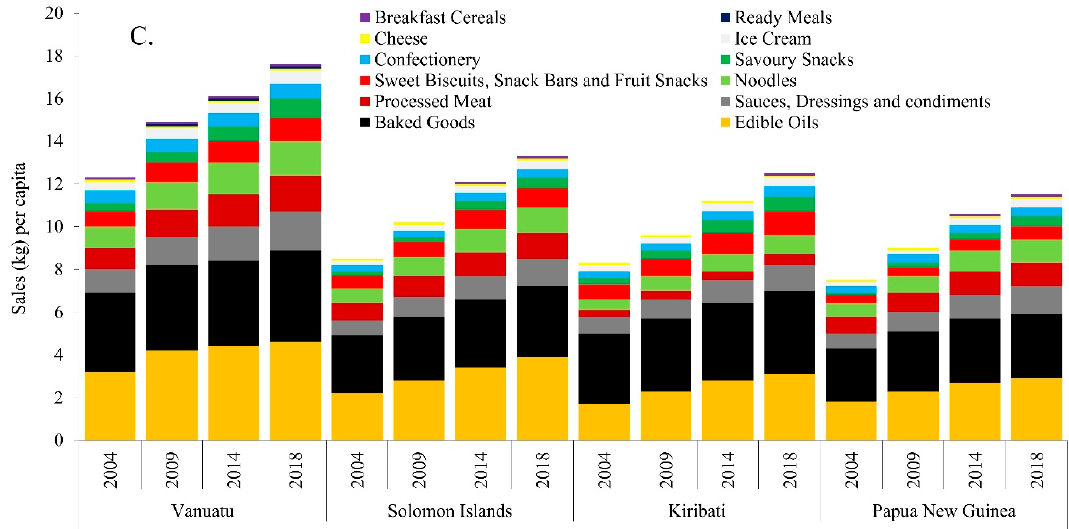
Figure 1. Per capita processed food sales in ( A ) high-income, ( B ) upper-middle income and ( C ) lower-middle income Pacific island countries, 2004–2018. Note: Different scales are used for each graph to demonstrate granularity in product categories; categories are ranked from highest (bottom) to lowest (top) volume and align with the same product category order in the figure keys.